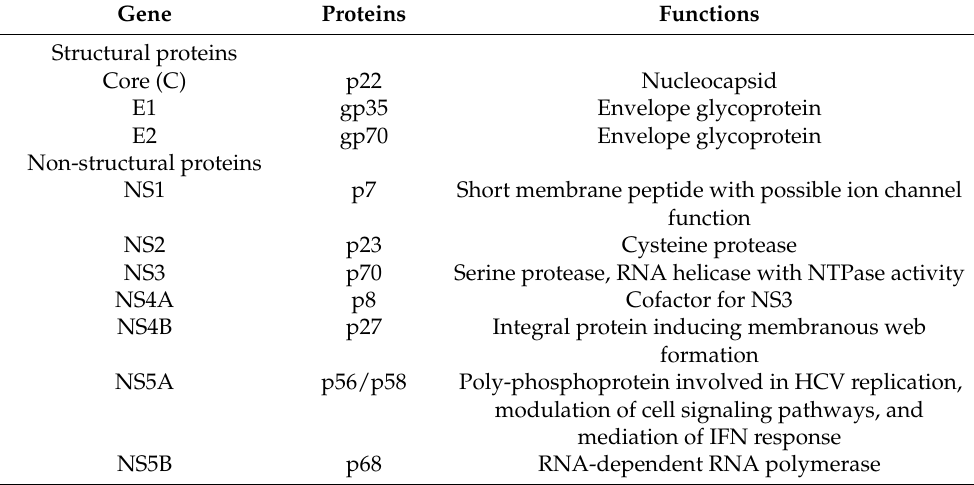
Table 2. Functions of HCV